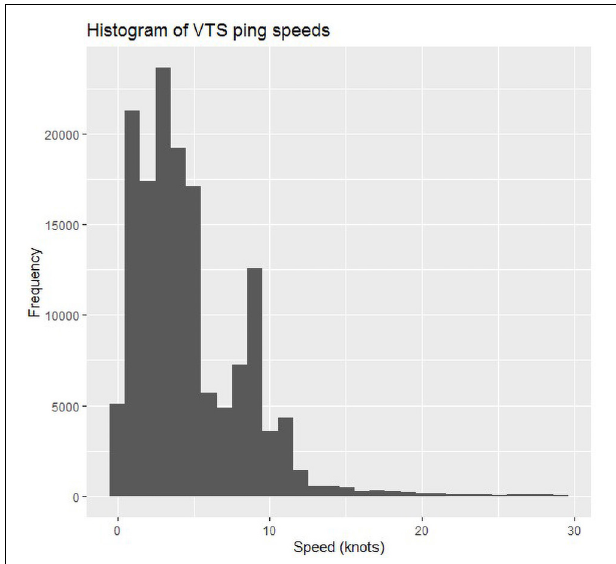
FIGURE 2 | Histogram of VTS ping frequency from the 9 pot-based fishing vessels included in the analysis.